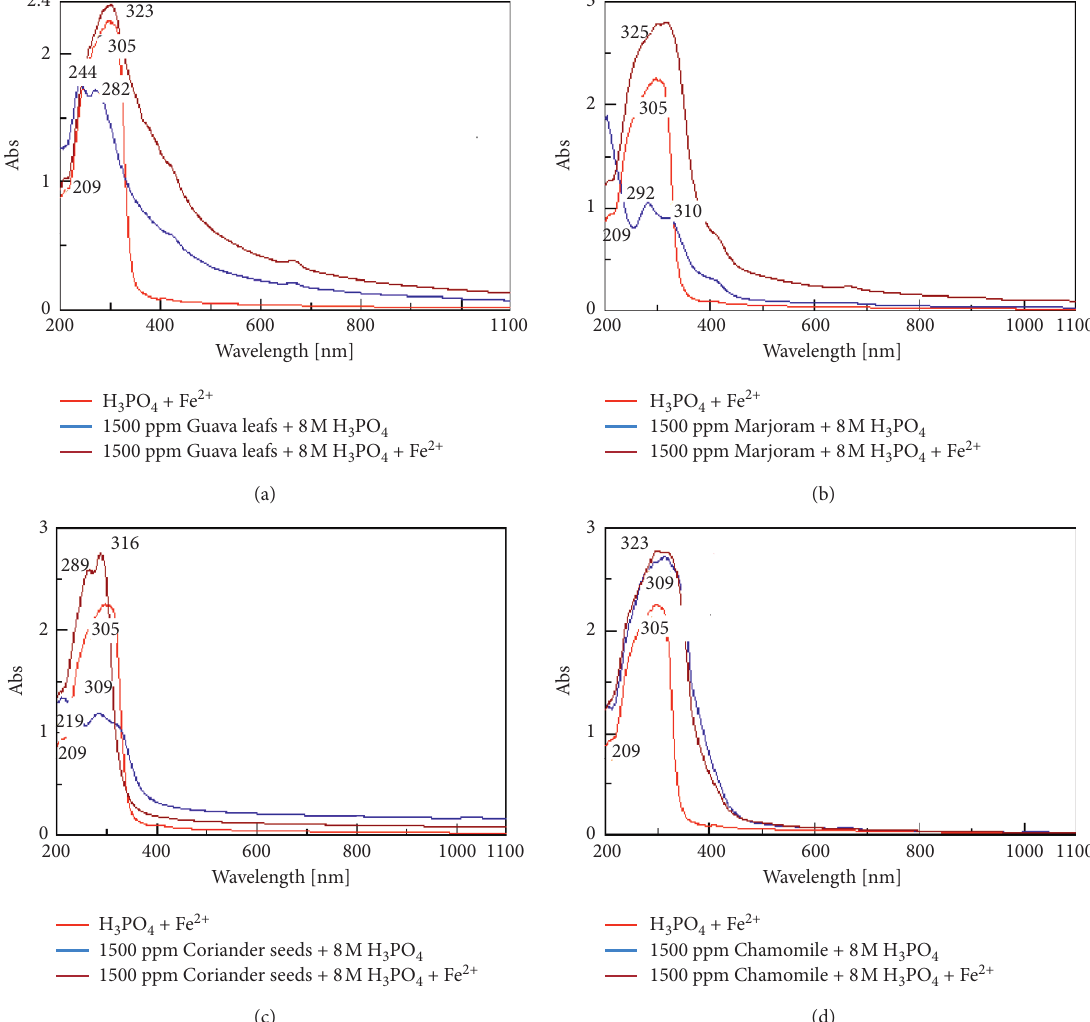
Figure 2: UV-visible spectrum of (a) guava leaves, (b) marjoram, (c) coriander seeds, and (d)